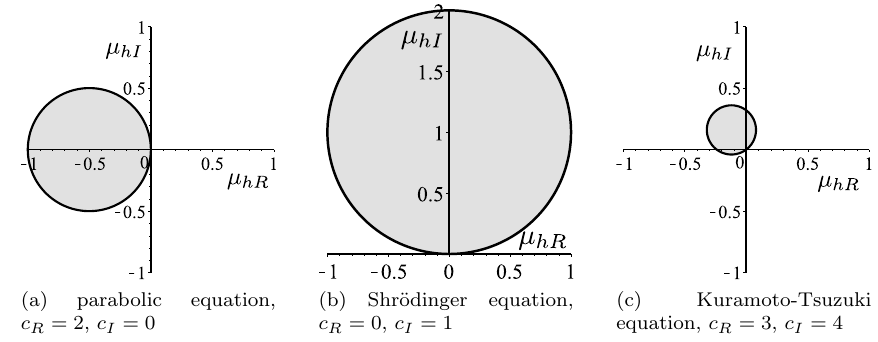
Figure 2. Stability regions for the explicit Euler approximation of different differential equations: a) parabolic equation, b) Schr¨odinger equation, c) Kuramoto-Tsuzuki